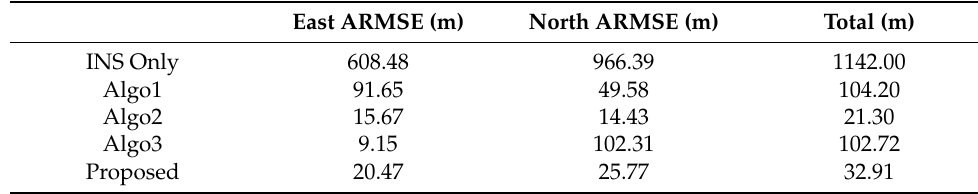
Figure 9. ( a ) Error curve of INS only, algo1, algo2, algo3 and the proposed method in east position; ( b ) error curve of algo1, algo2, algo3, and the proposed method in east position; ( c ) error curve of INS only, algo1, algo2, algo3, and the proposed method in north position; ( d ) error curve of algo1, algo2, algo3, and the proposed method in north position. Table 7. The ARMSE of each